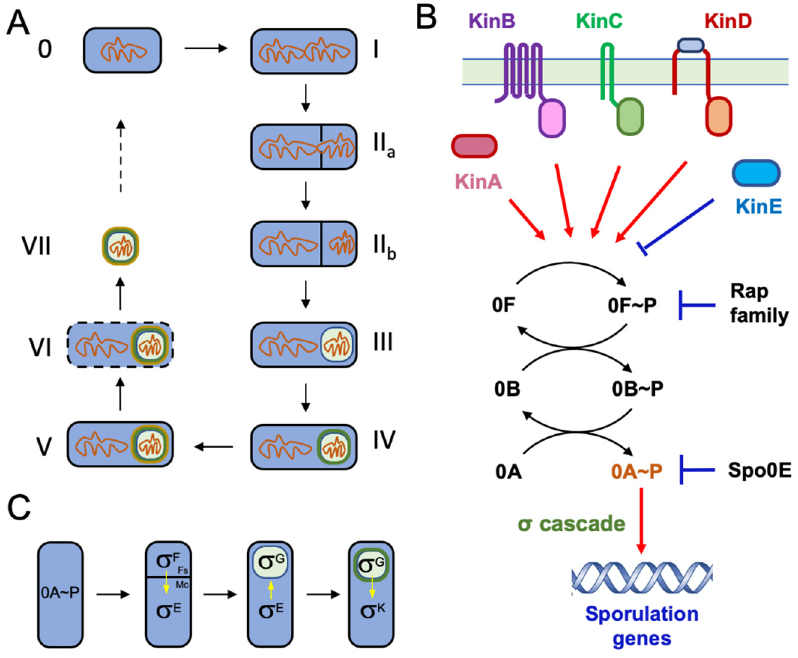
Figure 1. Diagram of spore formation and gene regulation network for sporulation in B. subtilis. ( A ) Diagram of spore formation. Shown are different stages of sporulation in B. subtilis from stage